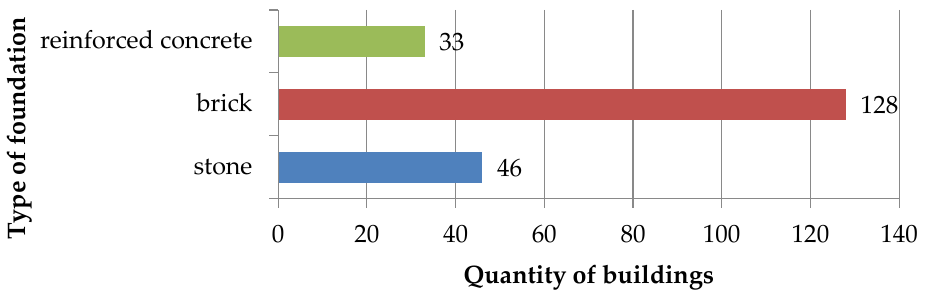
Figure 14. Distribution of data for the variable relating to the type of foundation.